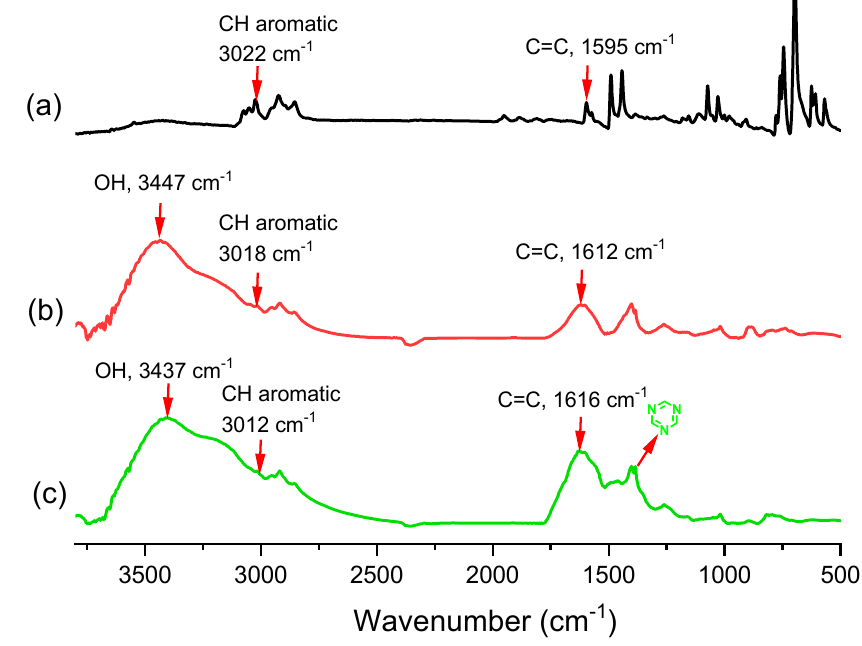
Figure 1. FTIR spectra of ( a ) TPE, ( b ) TPE-CPOP1, and ( c ) TPE-CPOP2.